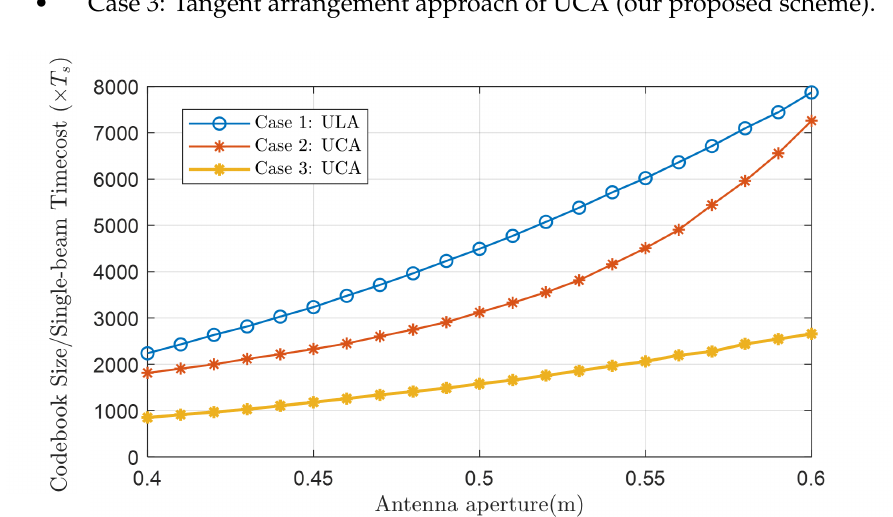
Figure 11. Comparison of codebook size/single-beam training time